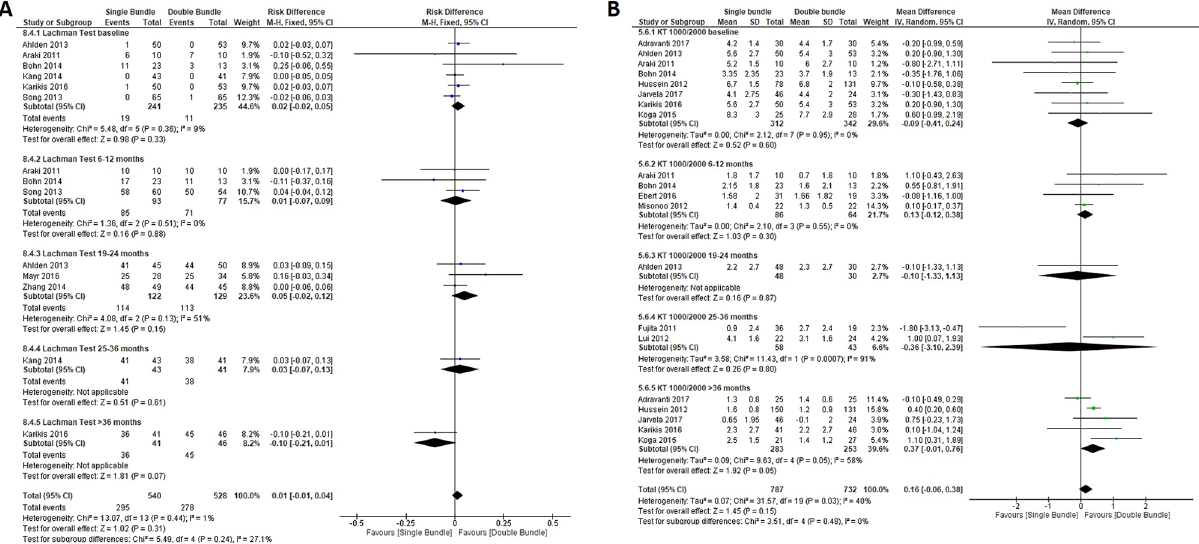
Figure 6. Forest plots of knee anterior stability data for single-bundle versus double-bundle reconstruction. Weights are from fixed effects for the Lachman test analysis and random effects for the KT 1000/2000 analysis. ( A ) Dichotomous data for the Lachman test (6 studies in the baseline period, 476 patients; 3 studies in the 6–12-month period, 170 patients; 3 studies in the 19–24-month period, 251 patients; 1 study in the 25–36- month period, 84 patients and 1 study in the > 36-month period, 87 patients). The heterogeneity was low: χ 2 = 13.07, df = 13 ( P = 0.44); I 2 = 1% (CI, confidence interval; M-H, Mantel–Haenszel). ( B ) Continuous data for KT-1000/2000 (8 studies in the baseline period, 654 patients; 4 studies in the 6–12-month period, 150 patients; 1 study in the 19–24-month period, 78 patients; 2 studies in the 25–36-month period, 101 patients and 5 studies in the > 36-month period, 536 patients). Heterogeneity was moderate: τ 2 = 0.07; χ 2 = 31.57, df = 19 ( P = 0.03);